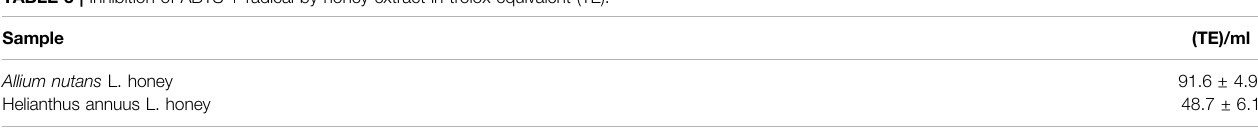
TABLE 3 | Inhibition of ABTS + radical by honey extract in trolox equivalent (TE).